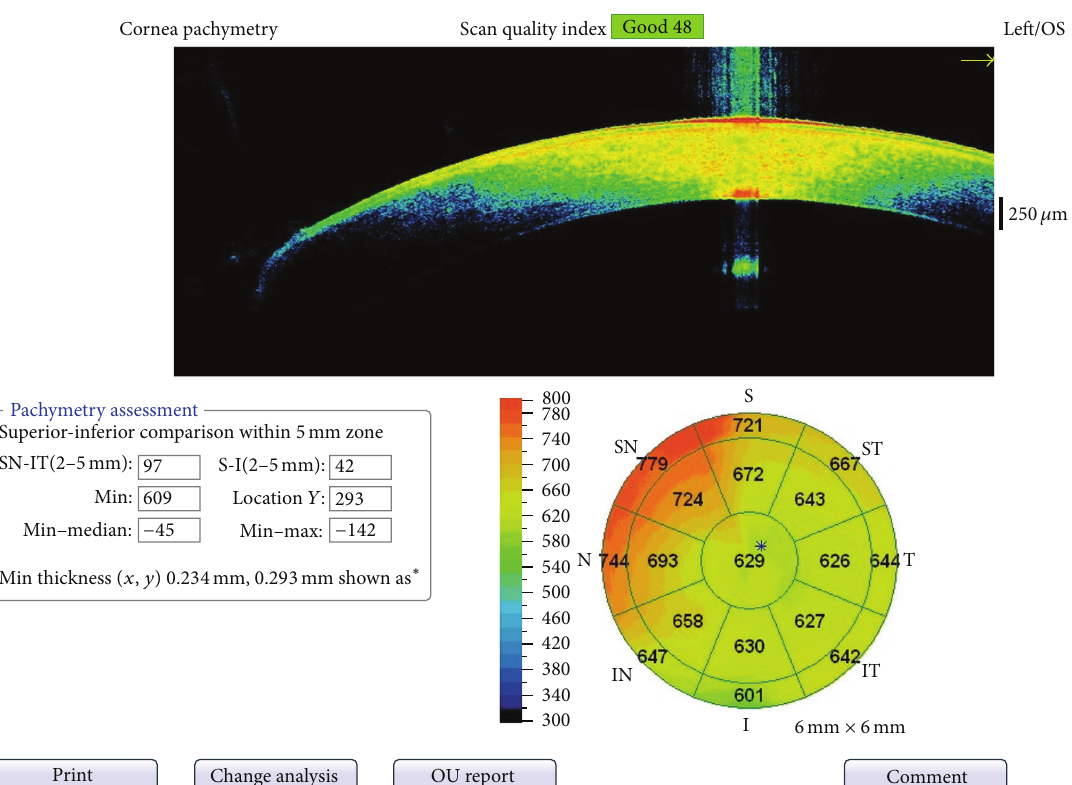
Figure 2: Printout of SD-OCT results showing measurement of CCT in three circles. The measurement in the innermost circle (2 mm) was accepted as the CCT value.